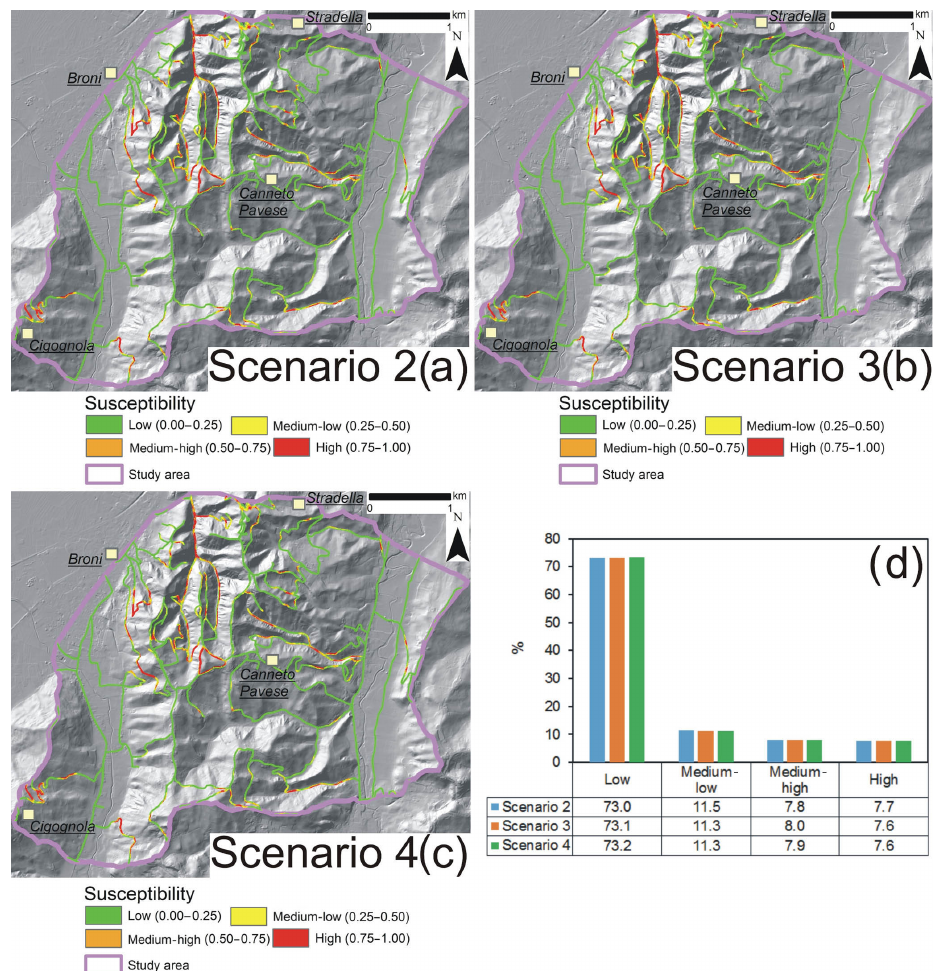
Figure 13. Maps of the susceptibility of the road segments to be affected by shallow landslides according to the different land use scenarios: (a) Scenario 2: land use distribution equal to that of 1980 (highest extension of vineyards); (b) Scenario 3: transformation of actual uncul- tivated areas in woodlands; (c) Scenario 4: increase in abandoned areas similar to those in the 1980–2015 period; (d) percentage of road network traits of different susceptibility classes for the considered